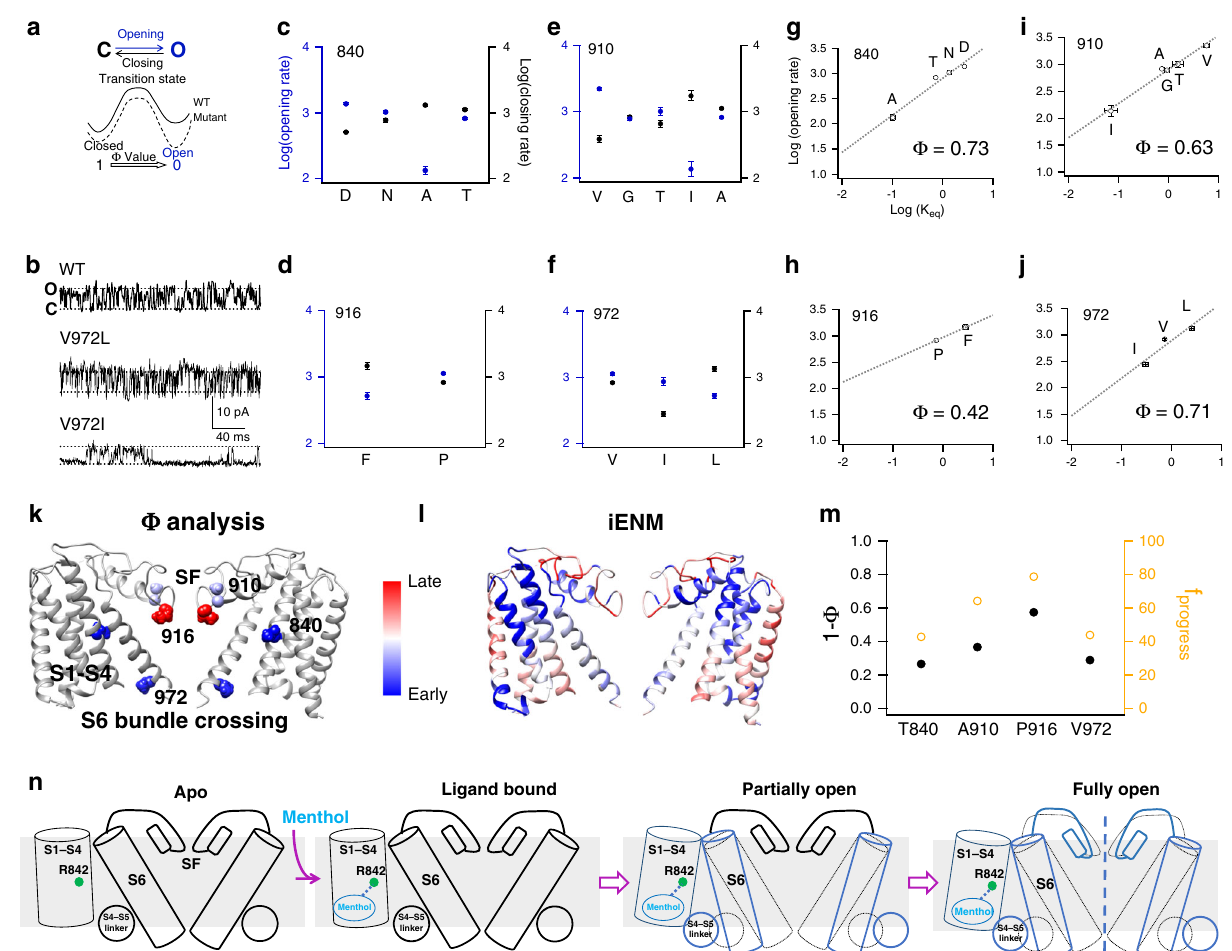
Fig. 6 Φ analysis and temporal sequence of events in menthol activation of TRPM8 channel. a The free-energy landscape of a closed-to-open transition. Point mutations, depending on its location, have asymmetrical effects on the free energies of closed and open state, which can be re fl ected in the kinetics of single-channel events. b Representative single-channel recordings of WT and mutants. c – f Measured opening and closing rates (circles in blue and black, respectively) for point mutations at individual sites. For each mutation at the same site, 3-to-5 independent single-channel recordings were analyzed. g – j Brønsted plots to determine the Φ value as the slope of linear fi tting (dashed line) for each site. All statistical data are given as mean ± s.e.m. k Φ values measured from single-channel recordings were mapped on the TRPM8 model. Residues moved early or late were colored in red or blue, respectively. Red and blue in color scale indicate relatively early and late movements, respectively. l f progress values calculated by iENM were mapped on the TRPM8 model. Residues moved early or late were colored in red or blue, respectively. m The Φ values (black) and f progress values (orange) matched well with each other at multiple residues. n A schematic diagram showing the temporal sequence of events upon menthol binding that lead to the full activation of TRPM8. All statistical data are given as mean ± s.e.m. Source data are provided as a Source Data fi